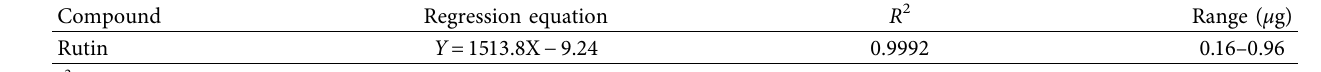
Table 3: Linear equation, R 2 , and range of rutin for quantitative determination.